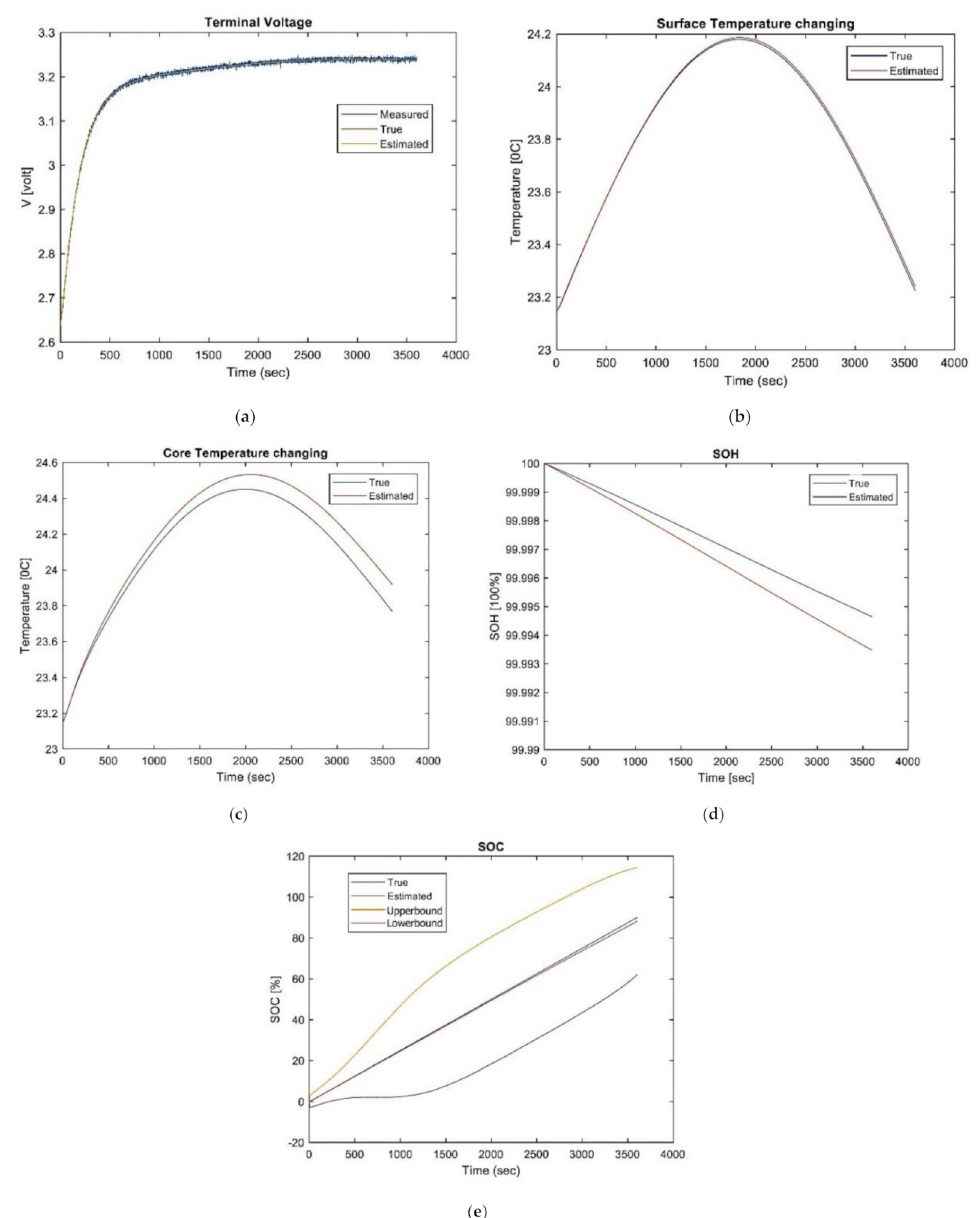
Figure 9. Temperature-measured observer estimation test using wrong initial values; ( a ) terminal voltage, ( b ) service temperature changing, ( c ) core temperature changing, ( d ) SOH, ( e )